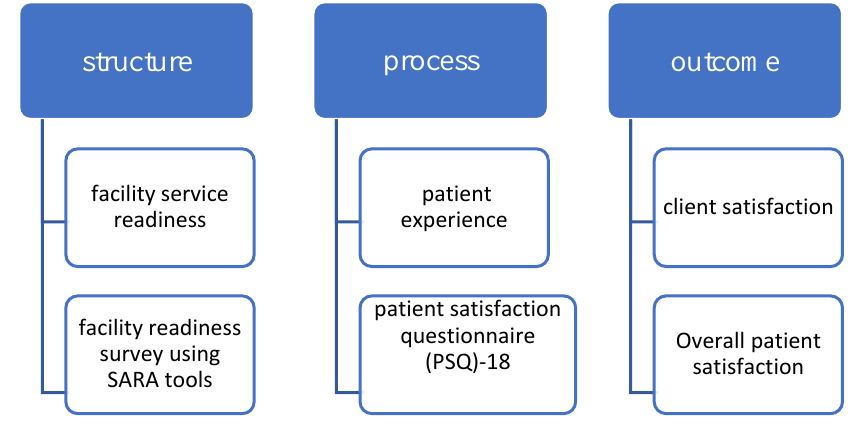
Figure 1. Illustrating the Donabedian model of care.